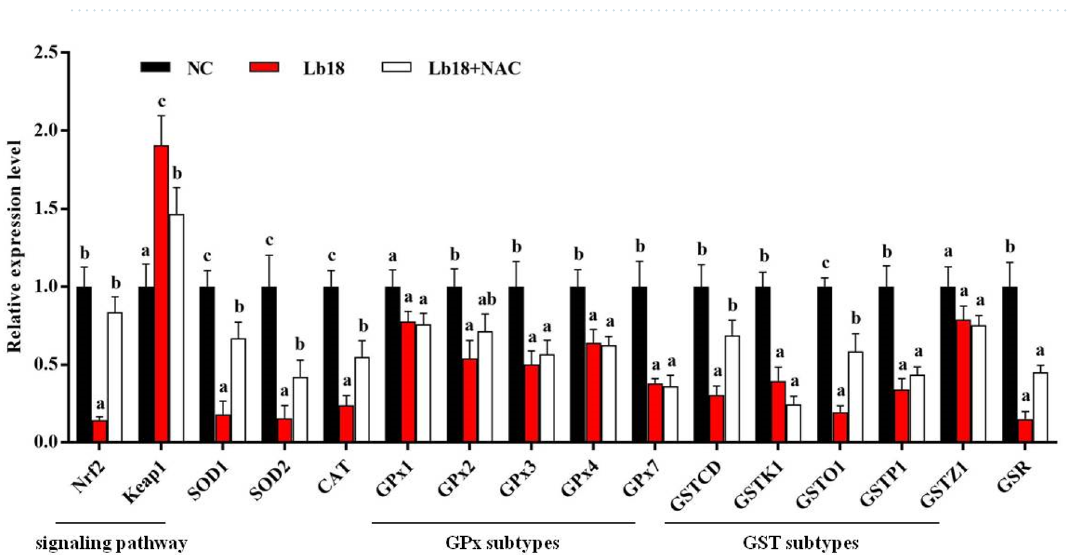
Figure 3. Relative expression of Nrf2 and antioxidant enzyme genes in the muscle of different groups. Values represent the mean ± S.E. (n = 3 replicate tanks), 3 turtles were sampled for each tank, the data with different letters show significant difference ( p <